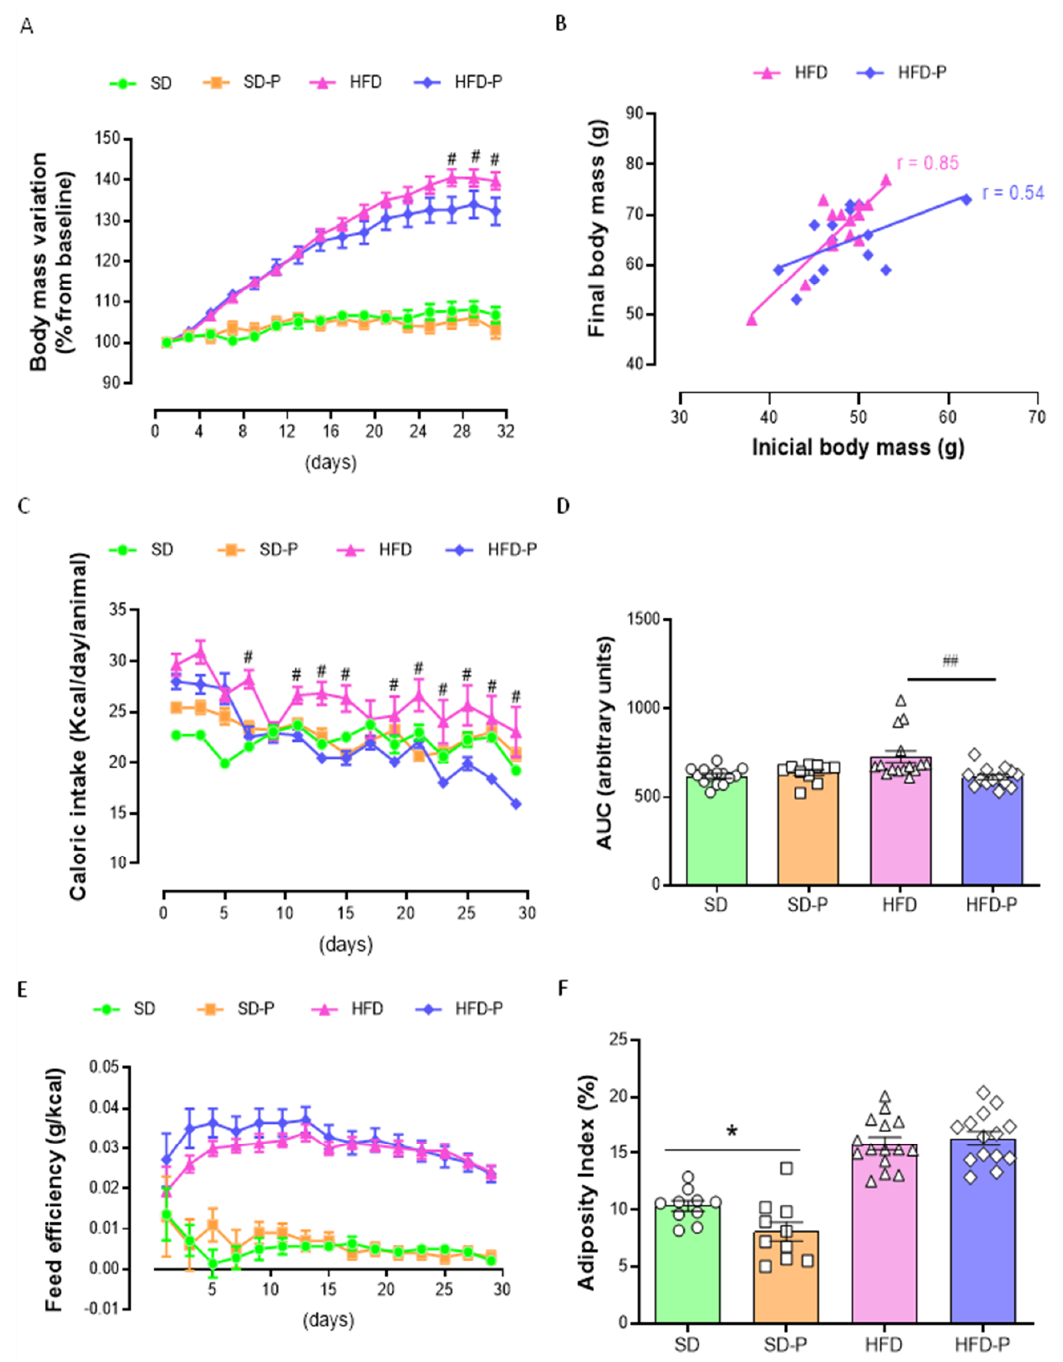
Figure 1. Pep19 treatment effects on body-weight gain, caloric intake, feed efficiency and adiposity index; standard diet (SD), high-fat diet (HFD), SD treated with Pep19 (SD-P), and HFD treated with Pep19 (HFD-P). Pep19 (1 mg/kg) was administered orally by gavage once a day during the